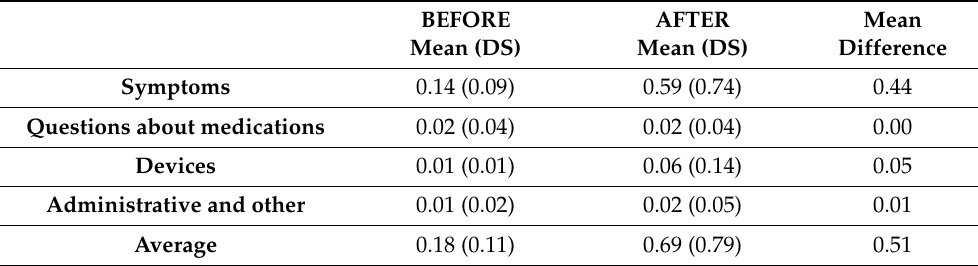
Table 7. Mean number of consultations in the periods before and after the training program. Ex- pressed as consults per week per